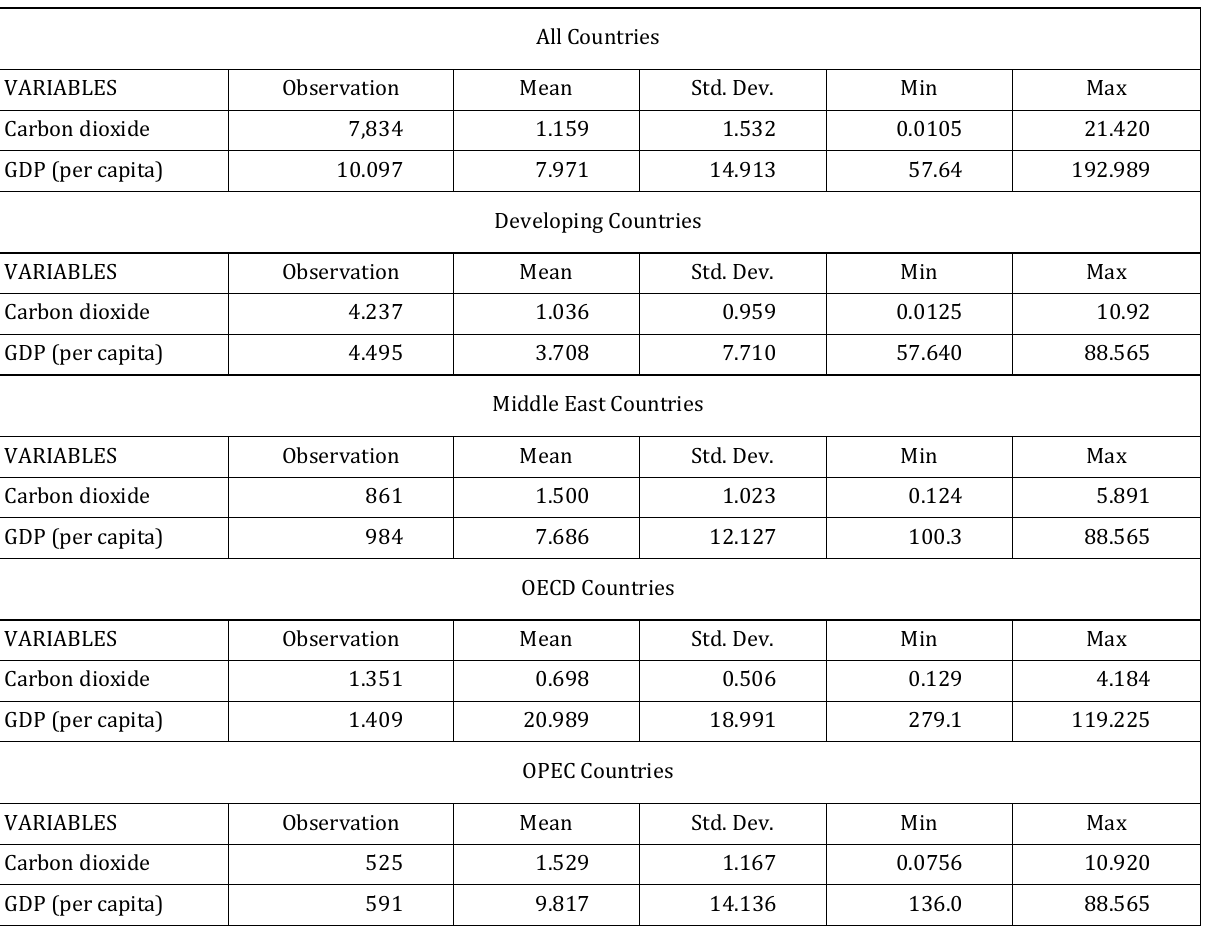
Table 2. Summary